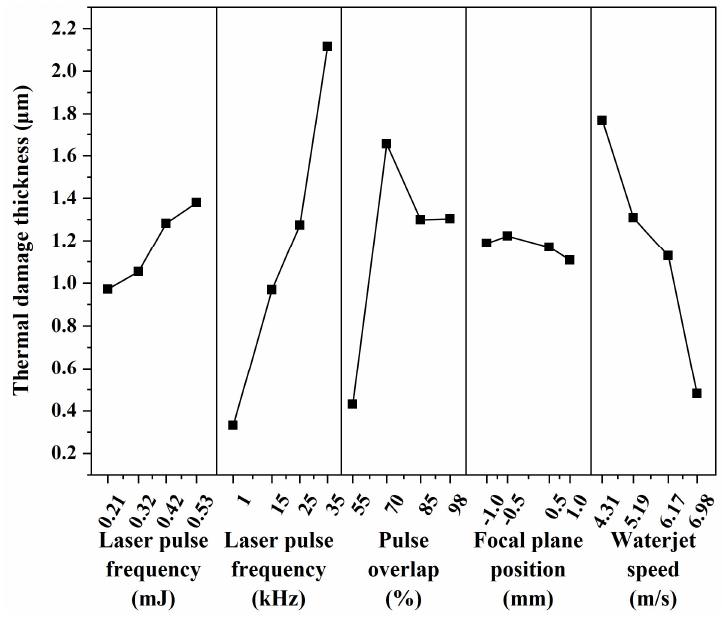
Figure 11. Main effect curve diagram.